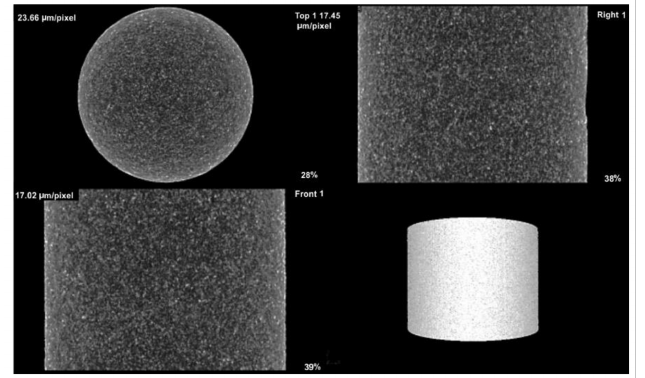
Figure 4. The Cu–graphite sample with 90 vol. % graphite investigated using X-ray tomography. Graphite is in dark grey (sample diameter is 8